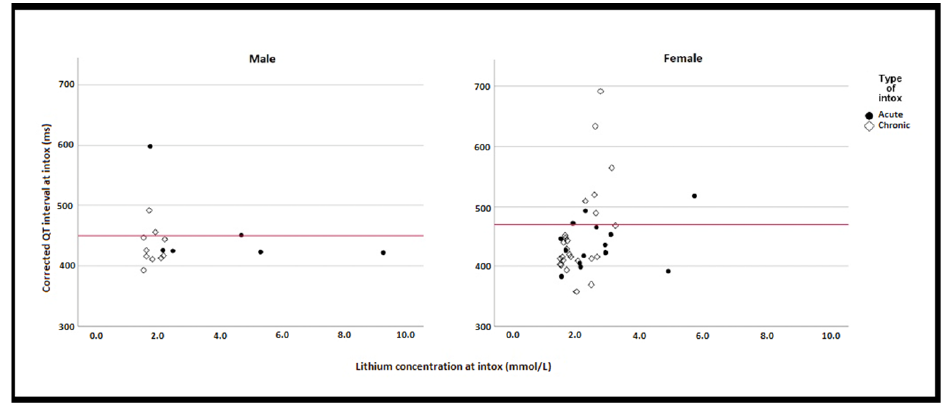
Figure 3. Relationship between lithium concentrations and QTc. Red lines indicating cut-off point for QT prolongation (450 ms for men and 470 ms for women). Intox: intoxication; ms: millisecond. Table 5. Episodes of lithium intoxication with QT prolongation.